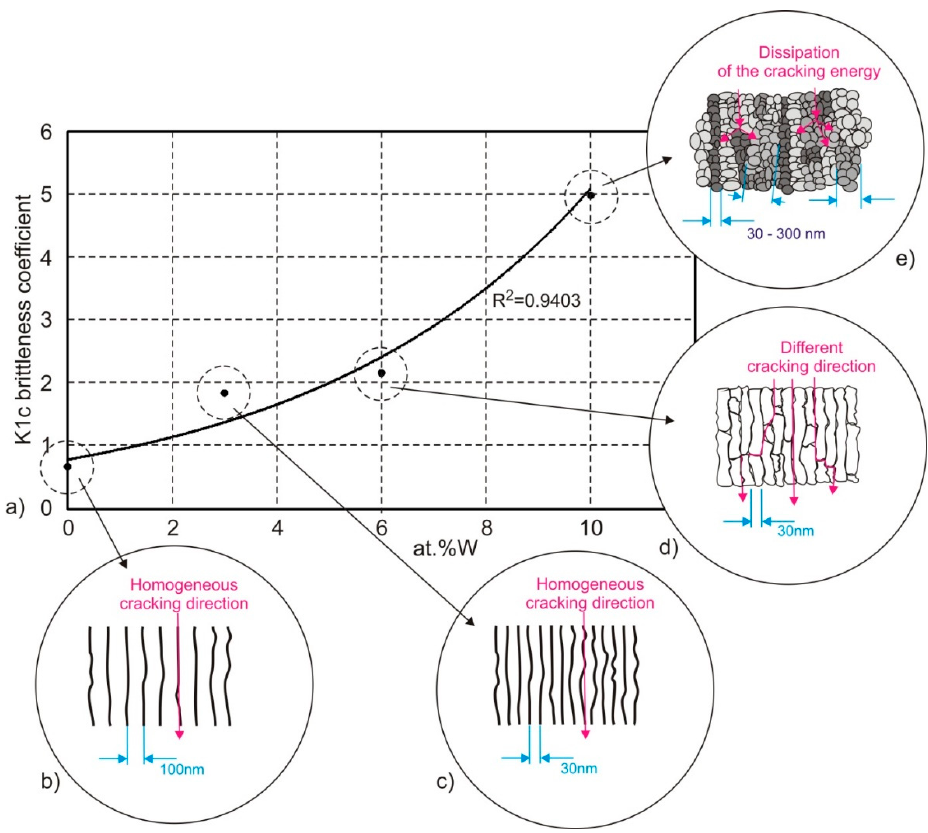
Figure 6. The results of the fracture toughness K IC analysis for TiB 2 and Ti-B-W coatings: ( a ) changes of values of K IC for TiB 2 and Ti-B-W coatings depending on the tungsten concentration (at. % W); ( b ) scheme of microstructure TiB 2 coating; ( c ) scheme of microstructure Ti-B-W (3%) coating; ( d ) scheme of microstructure Ti-B-W(6%) coating; ( e ) scheme of microstructure Ti-B-W (10%) coating.